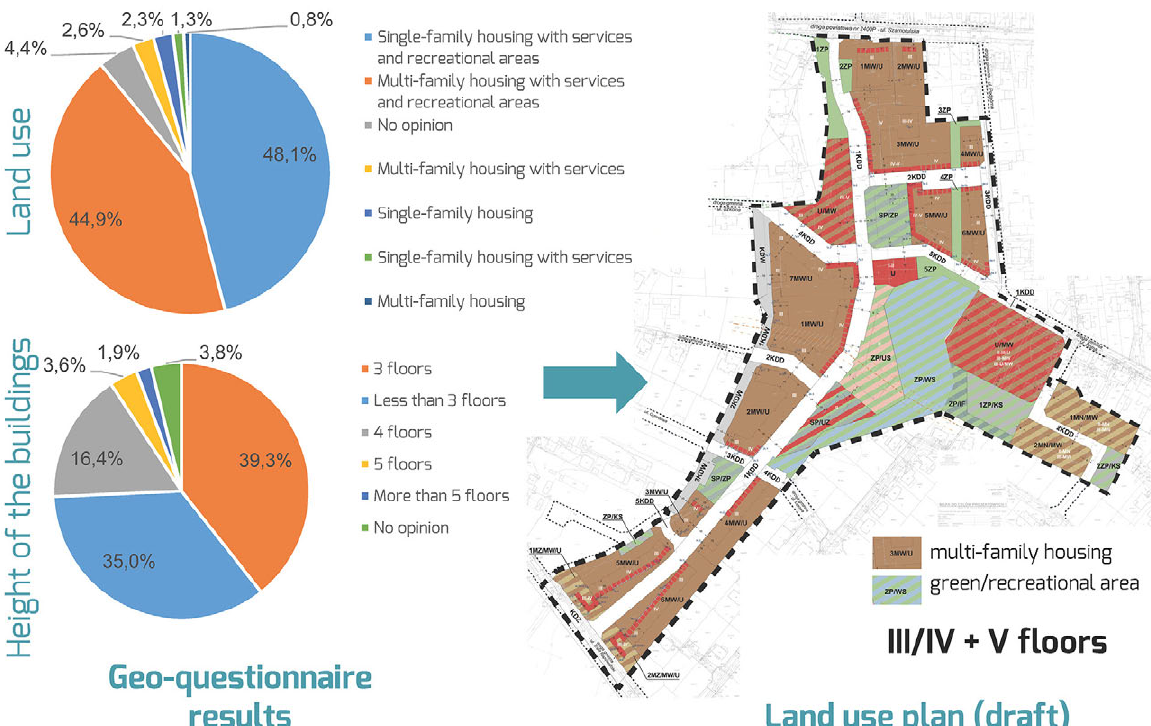
Fig. 14. Some results of geo-questionnaire and their influence on the formation of draft land use plan (by E. Bąkowska et